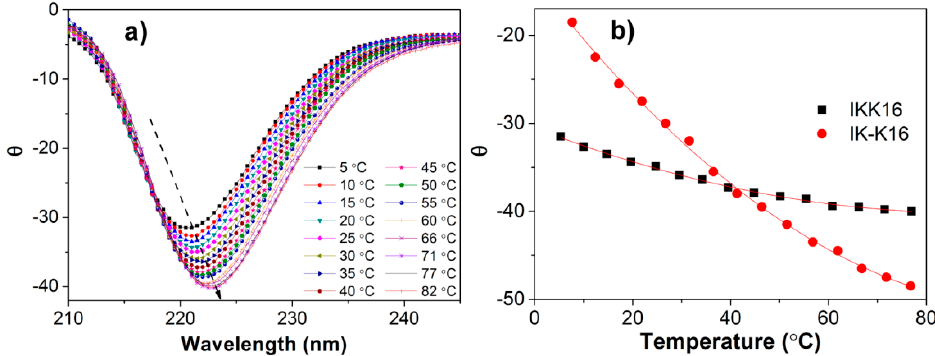
Figure 5. ( a ) The CD spectra of IKK16 solution (4.0 mM) at different temperatures. ( b ) Variation of the intensity of the negative peak at 220–225 nm as a function of